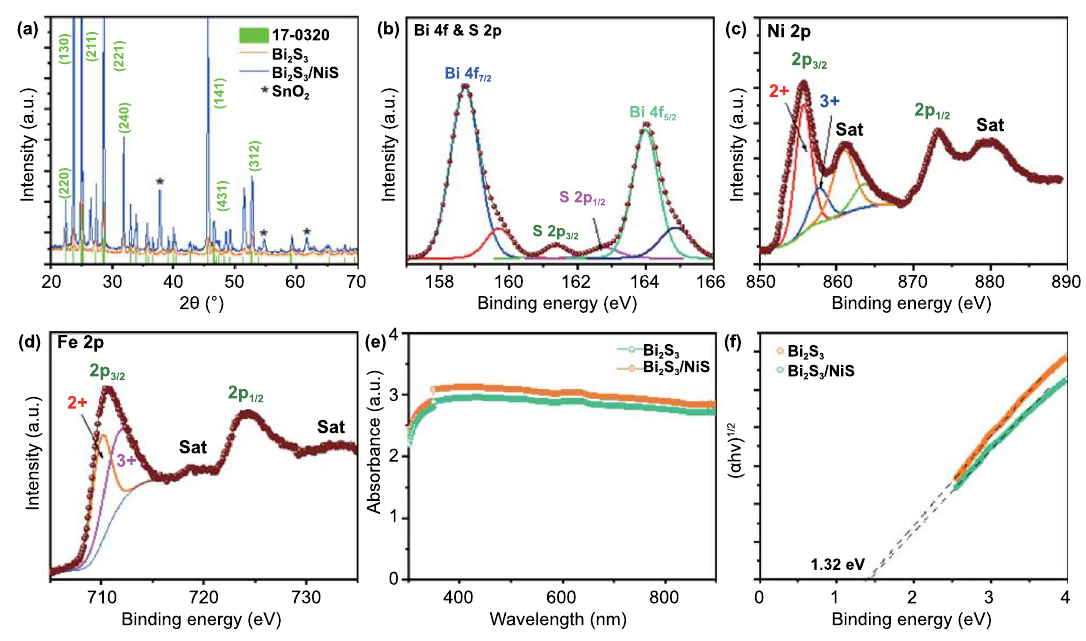
Fig. 1 a XRD spectrum of Bi 2 S 3 and Bi 2 S 3 /NiS photoanodes. High‑resolution XPS spectra of Bi 2 S 3 /NiS/NiFeO photoanode: b Bi 4f and S 2p, c Ni 2p, and d Fe 2p. e UV–vis spectra of Bi 2 S 3 and Bi 2 S 3 /NiS photoanodes measured with bare cleaned FTO as a reference to eliminate absorp‑ tion by air and FTO. f Tauc plots of Bi 2 S 3 and Bi 2 S 3 /NiS for direct allowed